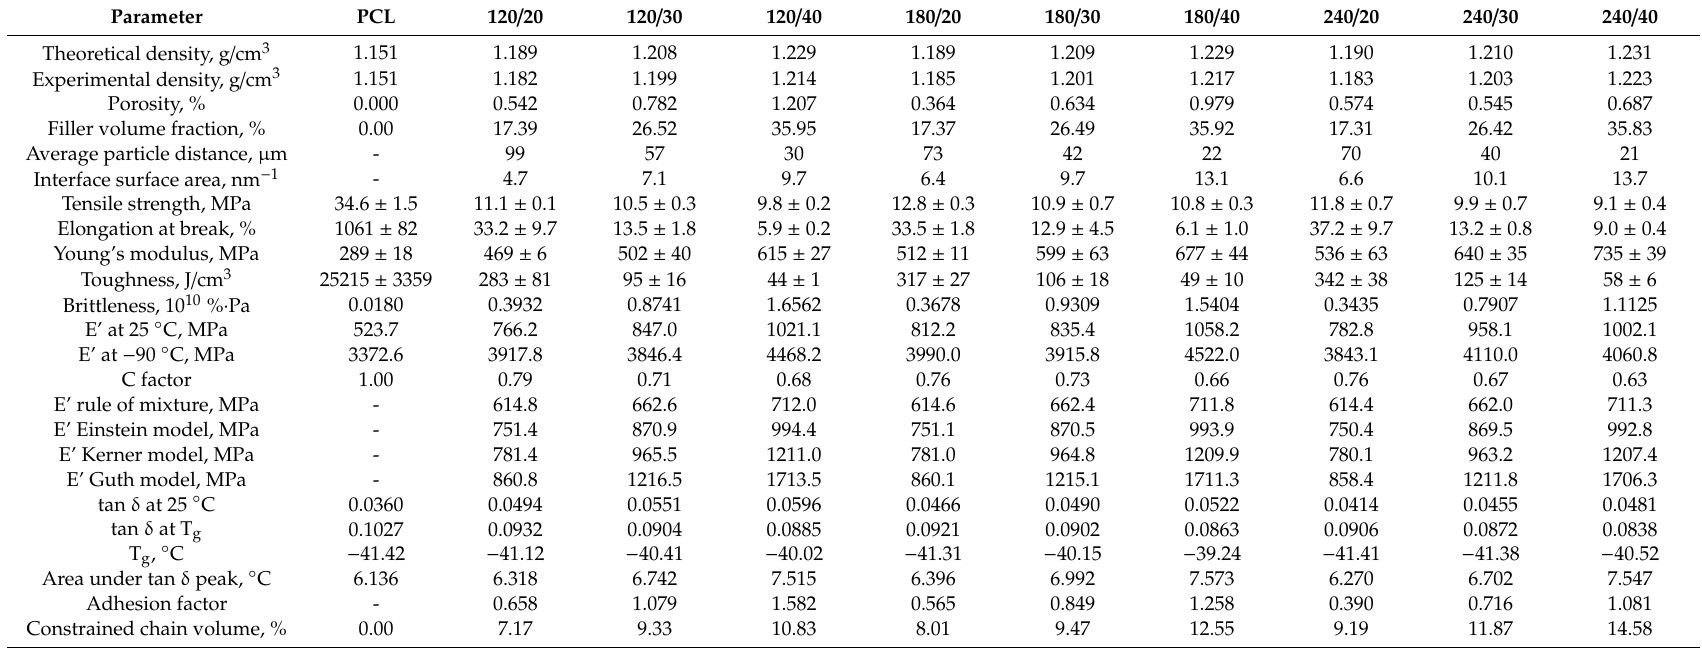
Table 1. Physical and mechanical properties of neat PCL and analyzed PCL / BSG